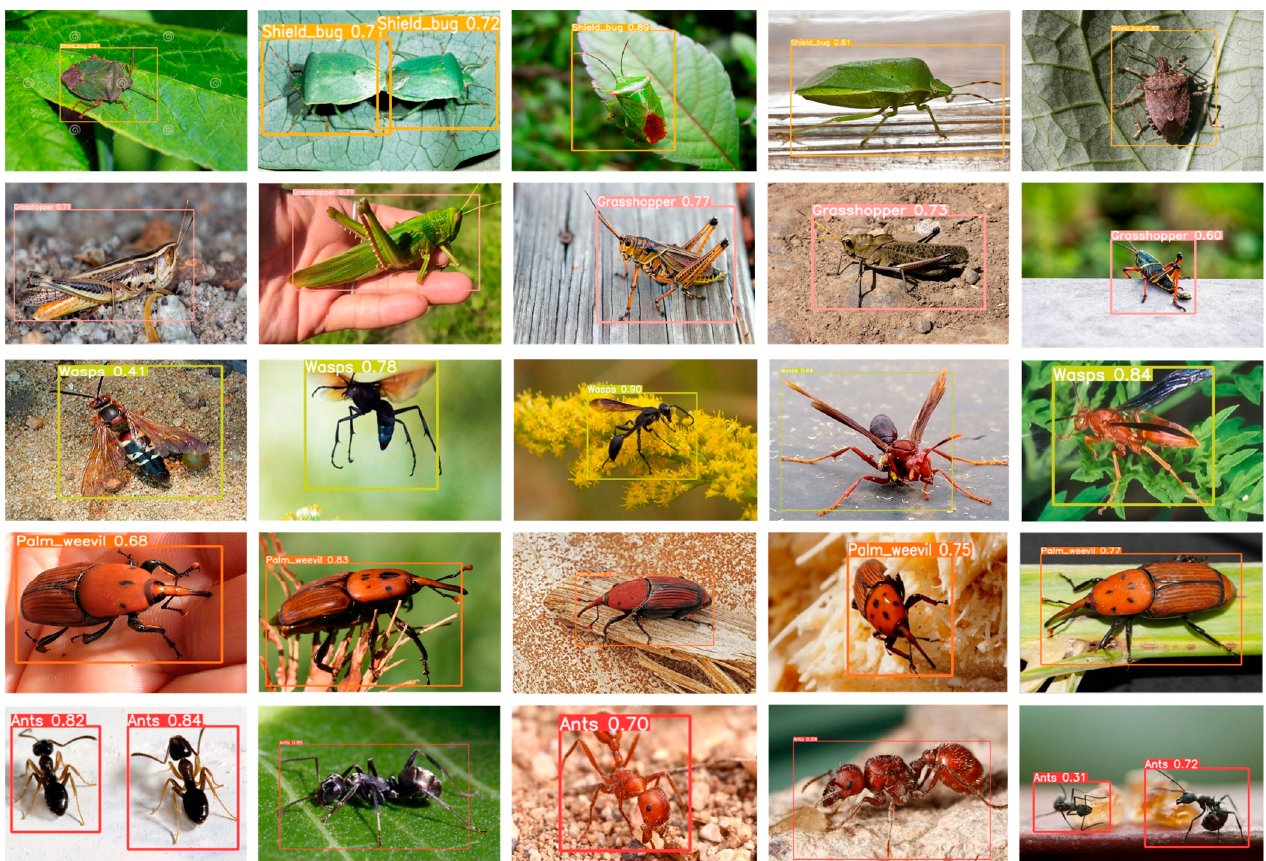
Figure 8. Represents the visual results of the proposed model which show the model effective analysis.